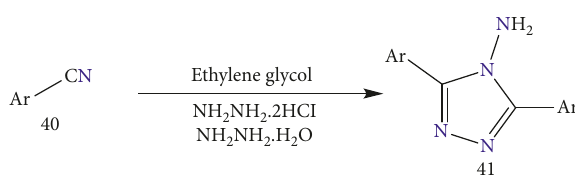
Scheme 17: Synthesis of 1,2,4-Triazoles Utilizing Microwave